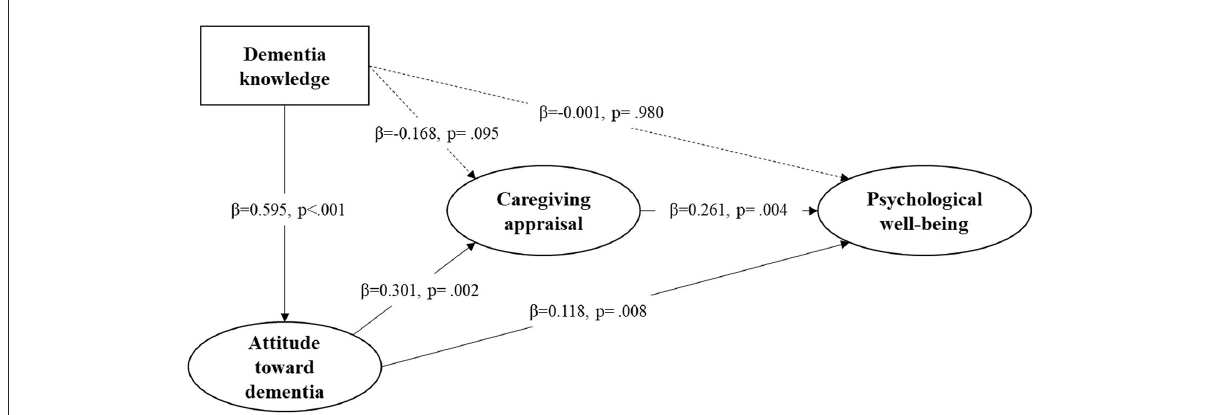
FIGURE2 The fitted structural equation model with the influencing mechanism of study variables. χ 2 = 44, p ( χ 2 ) = 0.078, CFI = 0.987, RMSEA = 0.038, GFI = 0.959, AGFI = 0.916, NFI = 0.949, RFI = 0.909, TLI = 0.976.